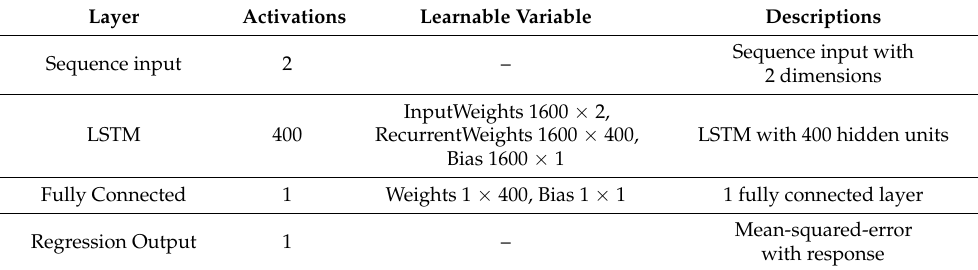
Table 4. Details of the implemented Long Short-Term Memory